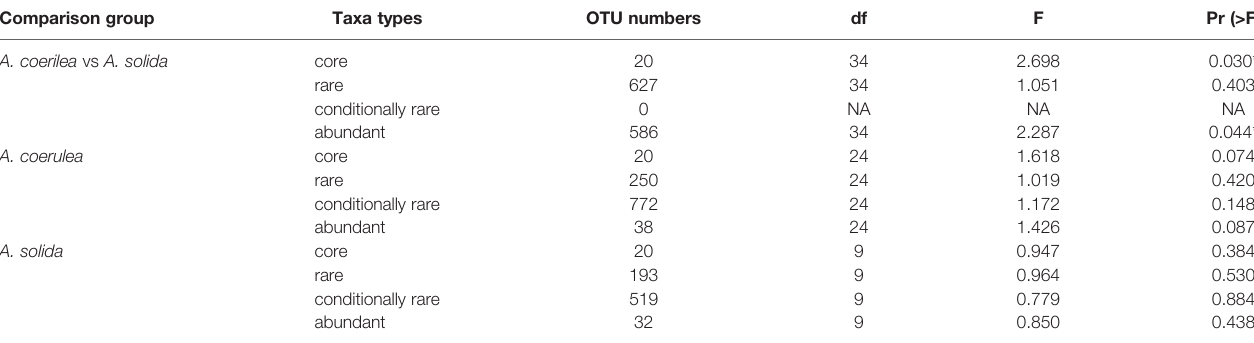
TABLE 2 | PERMANOVA tests of bacterial community structure of Aurelia polyps based on Bray – Curtis dissimilarities of OTU abundance. Comparison group